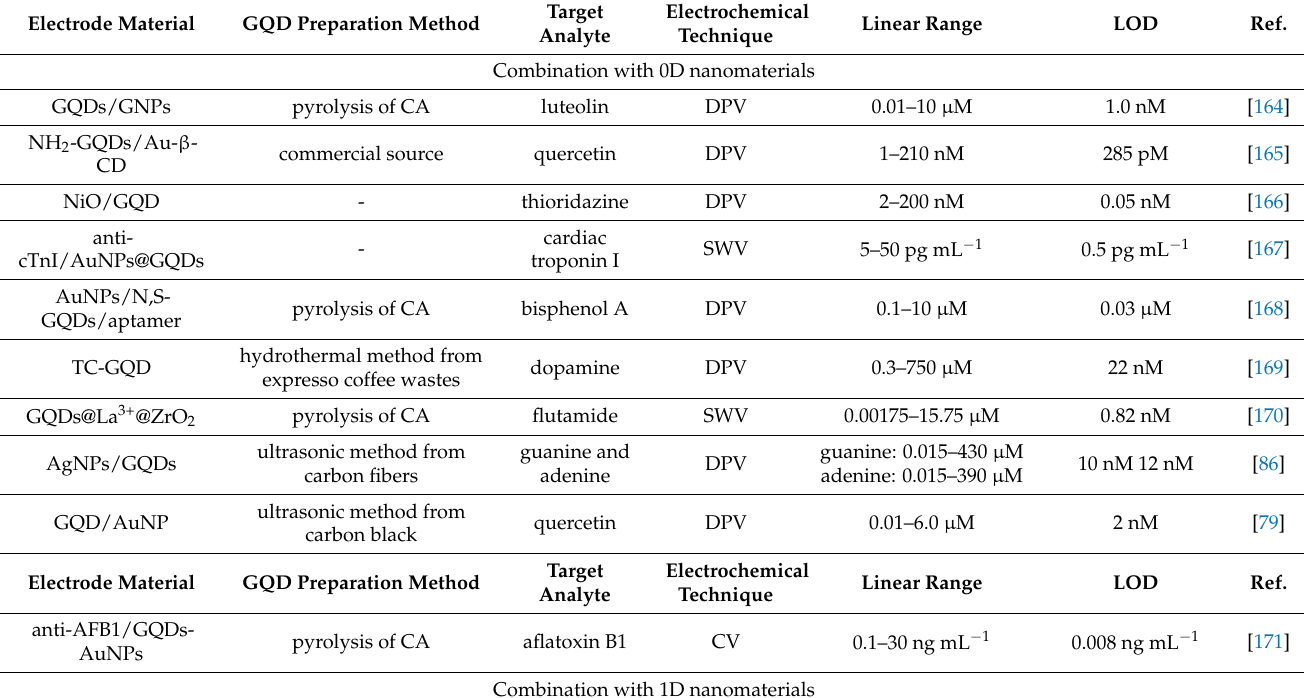
Table 1. Some examples of GQD-based nanocomposites for electrochemical (bio)sensing. Electrode